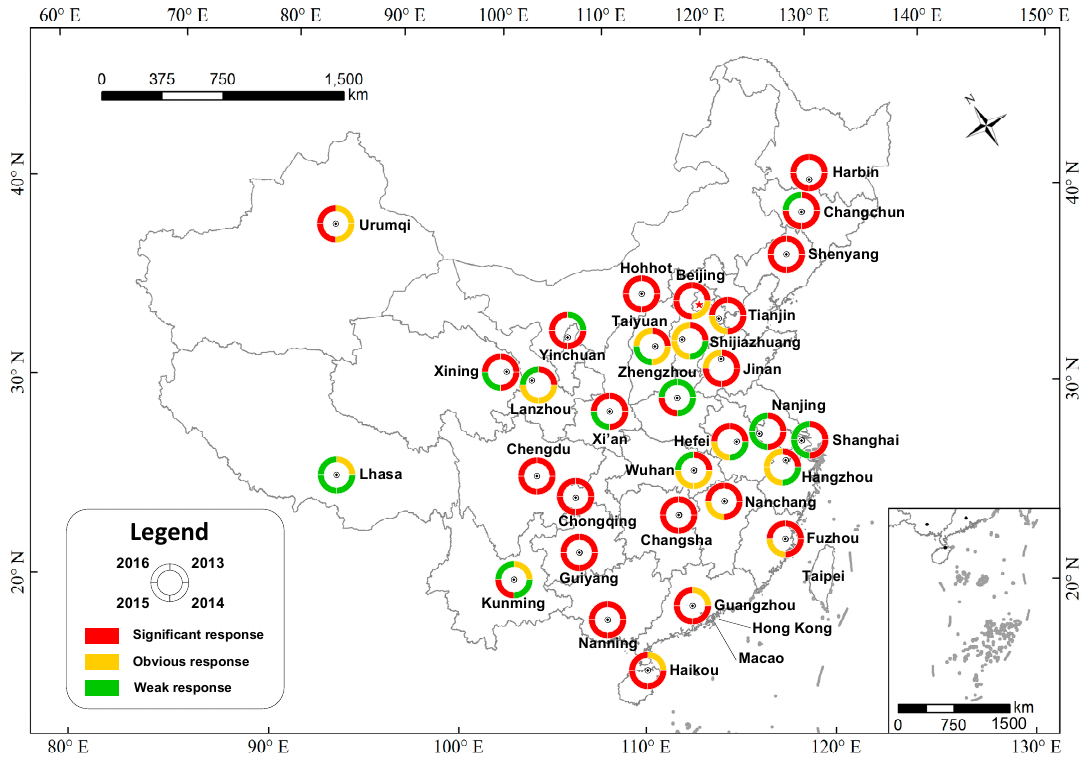
Figure 5. PM 2.5 response to fireworks discharge in 31 provincial capital cities during the 2013–2016 New Year celebration